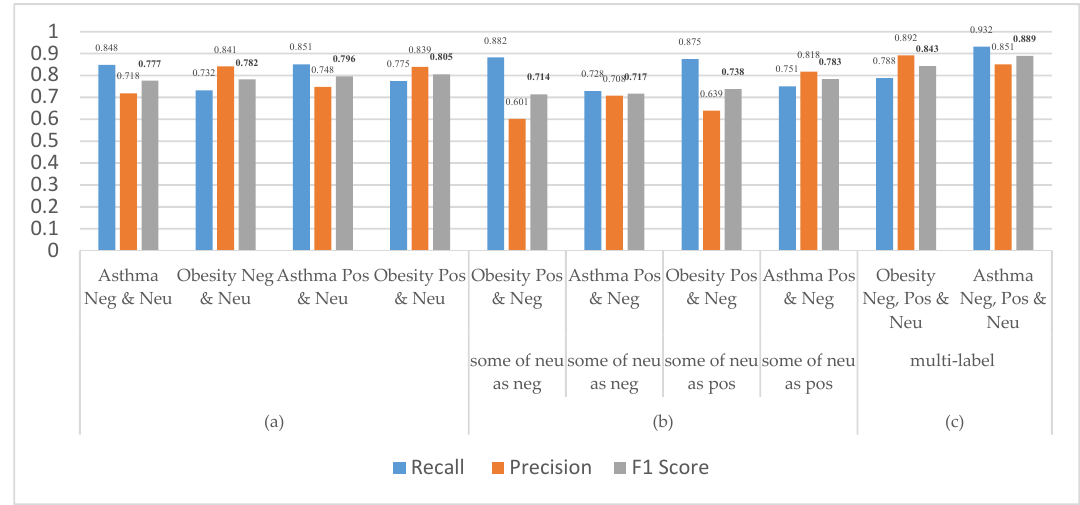
Figure 6. Performance statistics based on comparison between binary classification results with different cases (Pos, Neg or/and Neu), and multi ‐ label classification, by using our method: ( a ) the results in terms of recall, precision, and the F1 measure; ( b ) the results in terms of recall, precision, and the F1 measure; ( c ) the results in terms of recall, precision, and the F1 measure.